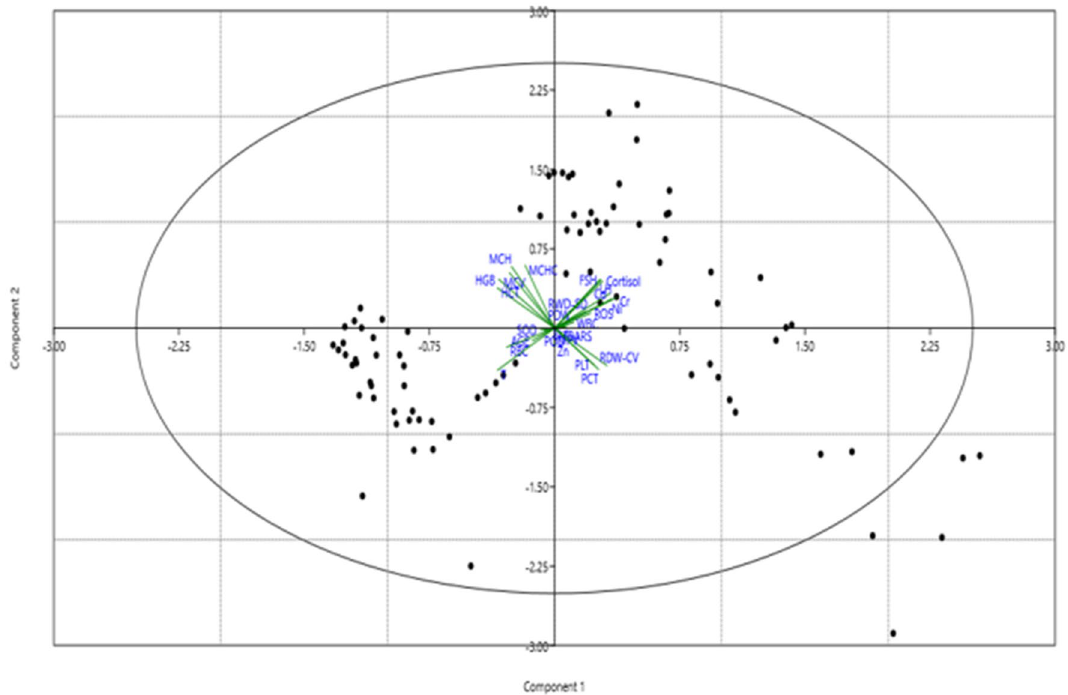
Figure 4. Scatter plot of principal component analysis (PCA) Component 1 versus PCA Component 2 scores. Each point is represented by a symbol denoting its analytical cluster and a line connecting it to the cluster